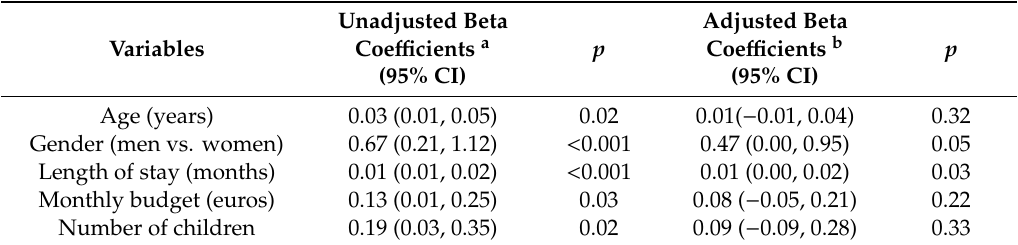
Table 4. Multiple linear regression model of dietary diversity score (DDS) by background characteristics among asylum seekers living at reception centers in southeastern Norway ( n =